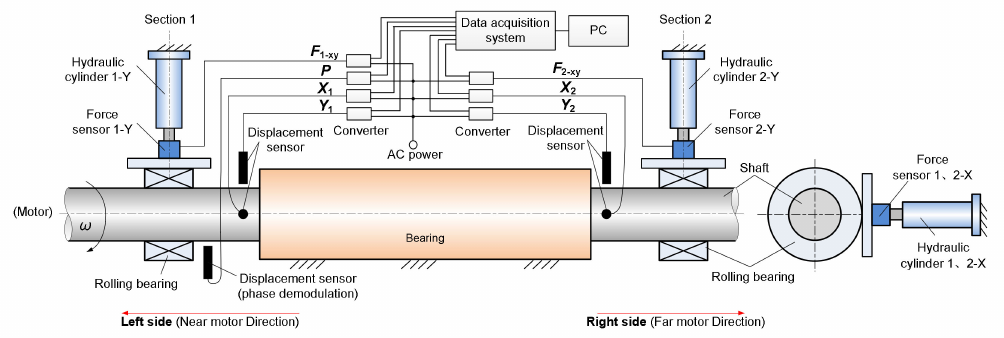
Figure 3. Measurement